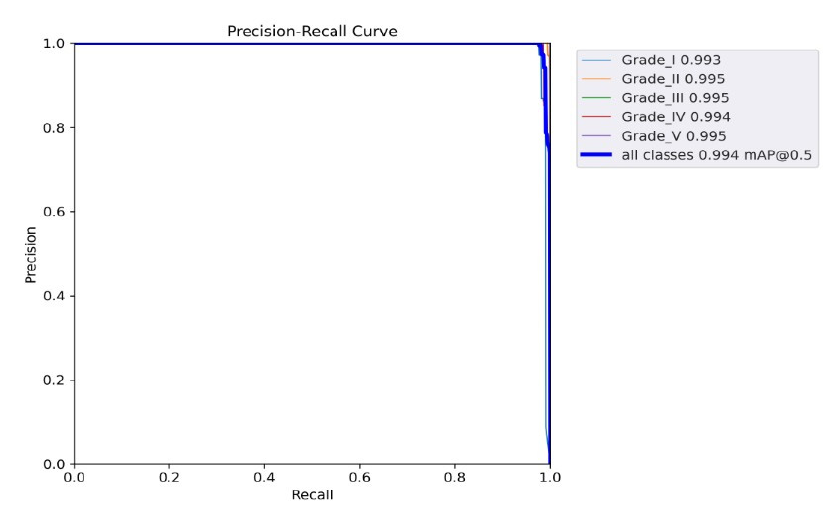
Figure 10. Recall–precision graph showing the relationship between recall and precision.